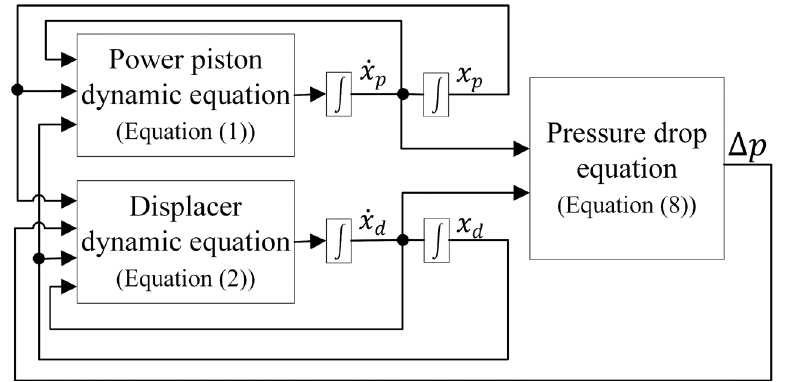
Figure 2. FPSE block diagram [15].